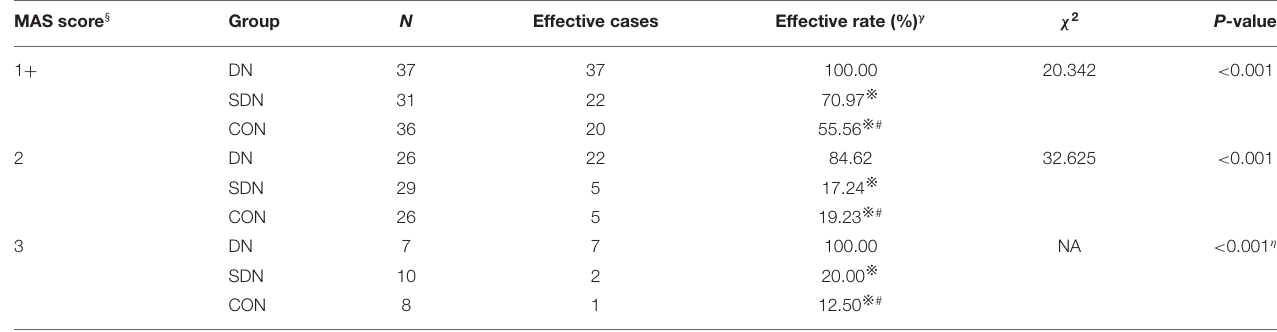
TABLE 5 | Immediate effective rate of fingers 2–5 spasticity relief in patients with different degree of